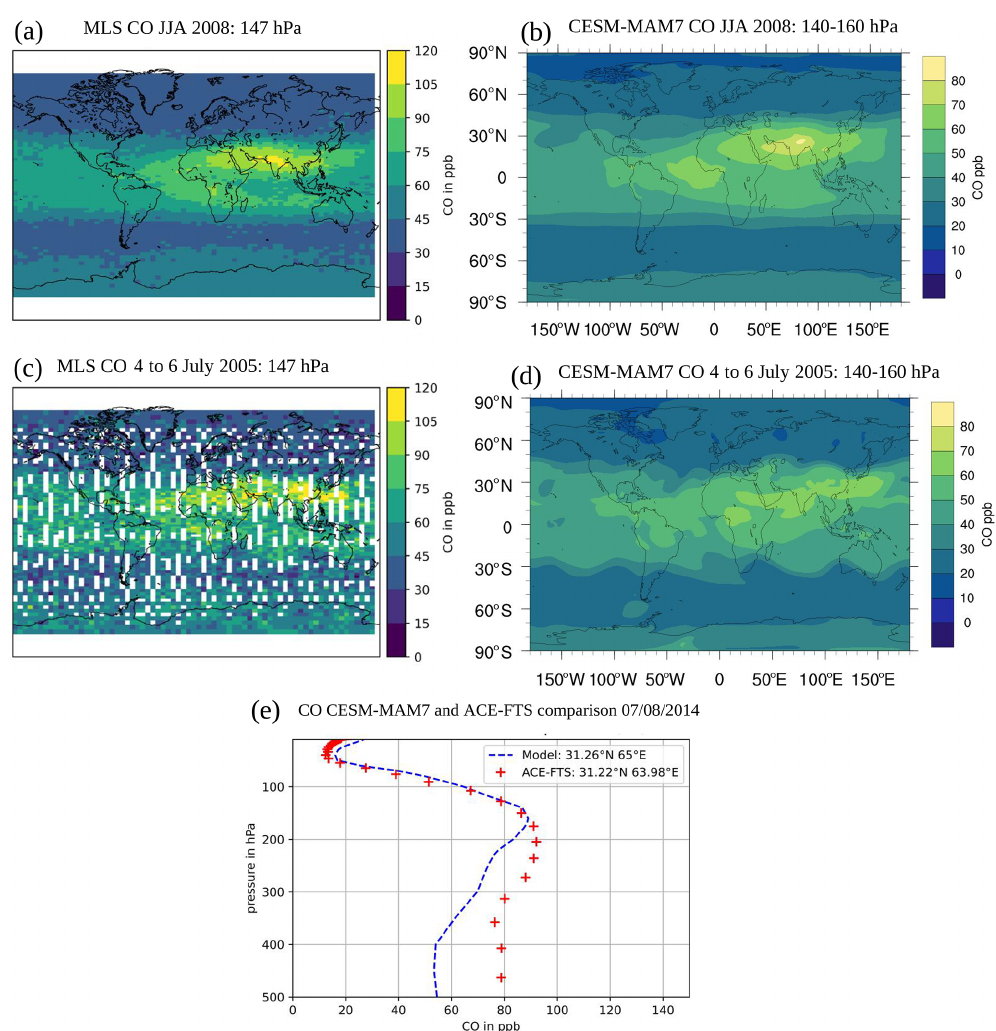
Figure 1. (a) Average MLS CO mixing ratio distribution for June–July–August 2008 at 147hPa pressure level and (b) average CESM- MAM7 CO mixing ratio distribution for June–July–August 2008 between 140 and 160hPa. (c) Three-day average for the MLS CO mixing ratios at 147hPa (4 to 6 July 2005) and (d) respective CESM-MAM7 simulations, for 4 to 6 July 2005 between 140 and 160hPa. (e) ACE- FTS and CESM-MAM7 vertical CO profiles for 7 August 2014 at 31.22 ◦ N–63.98 ◦ E, 14:30UTC and 31.26 ◦ N, 65.00 ◦ E, and 12:00UTC,